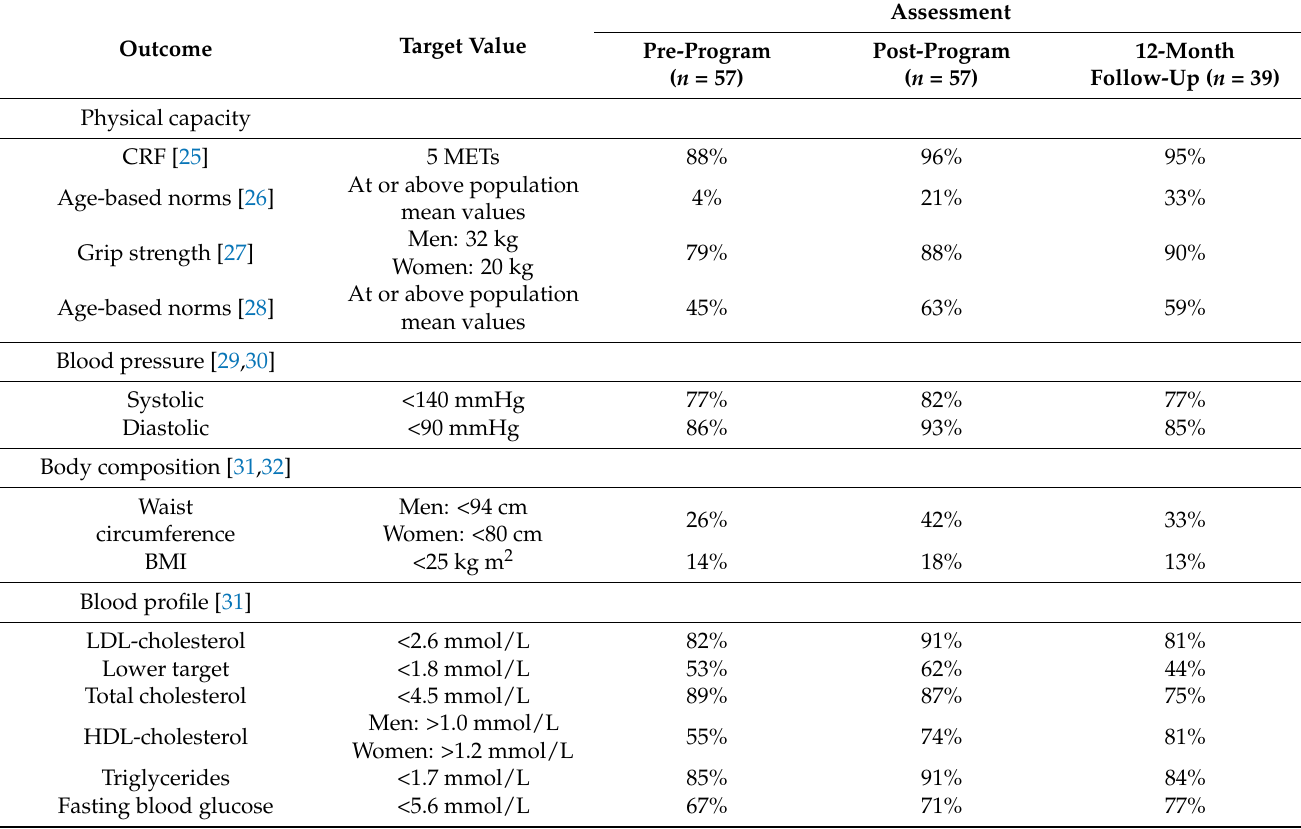
Table 2. Proportion of participants meeting cardiac rehabilitation target values for cardiovascular risk